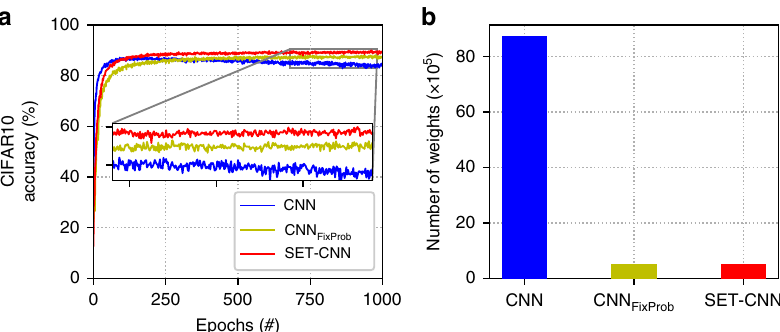
Fig. 7 Experiments with CNN variants on the CIFAR10 dataset. a Models performance in terms of classi fi cation accuracy (left y axes) over training epochs ( x axes). b The number of weights of the three models on each dataset. The convolutional layers of each model have in total 287,008 weights, while the fully connected (or the sparse) layers on top have 8,413,194, 184.842, and 184,842 weights for CNN, CNN FixProb , and